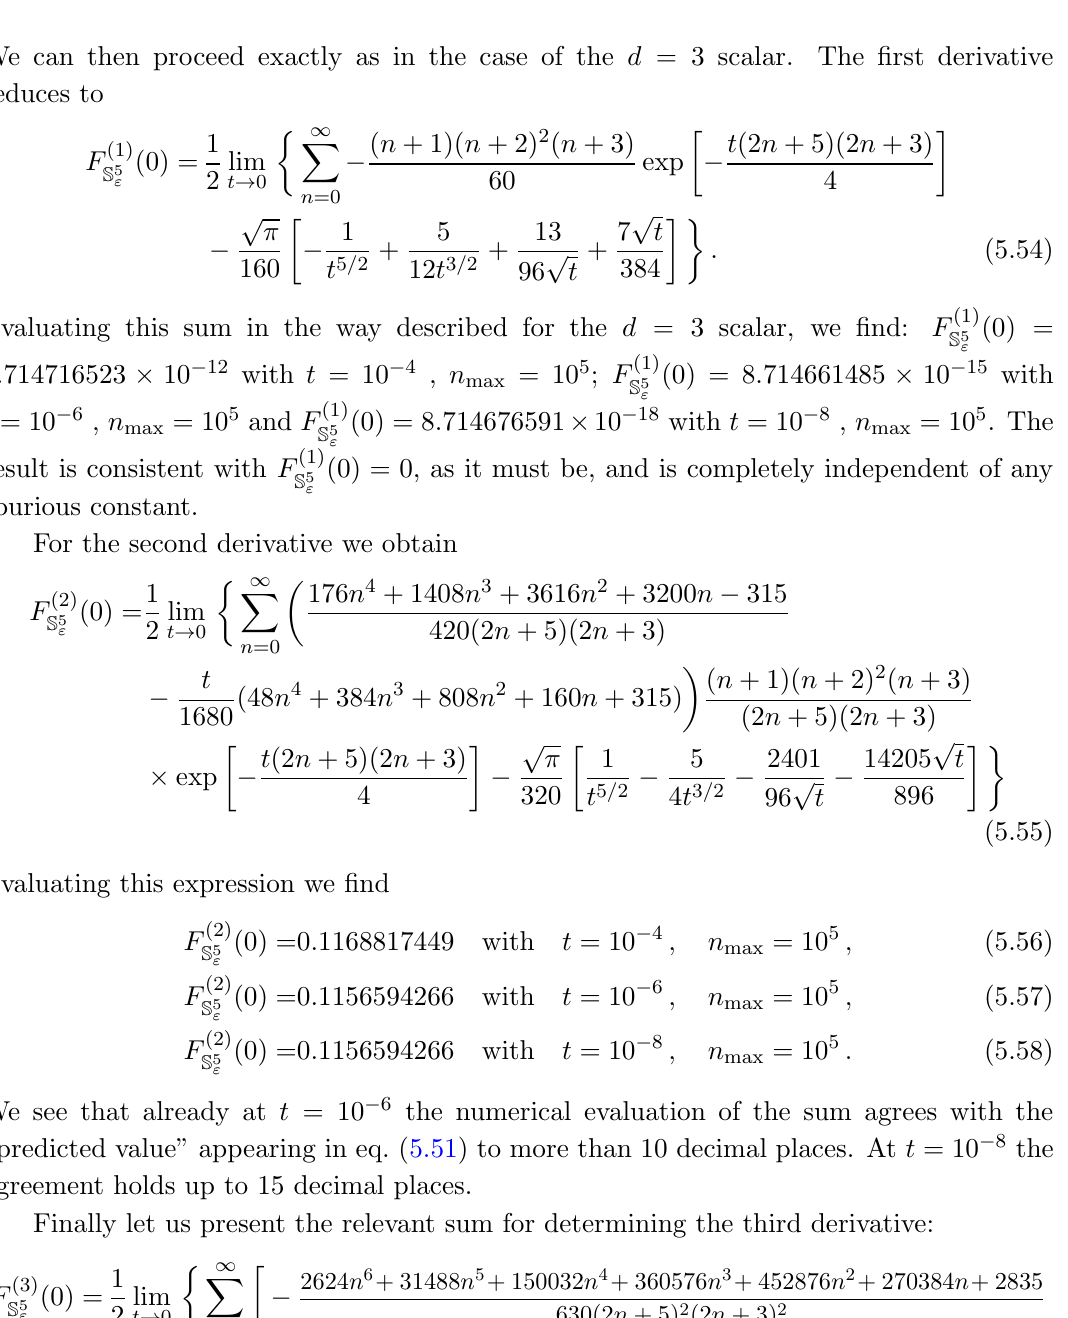
Table 2 . Values of derivatives of F S 5 for a conformally-coupled